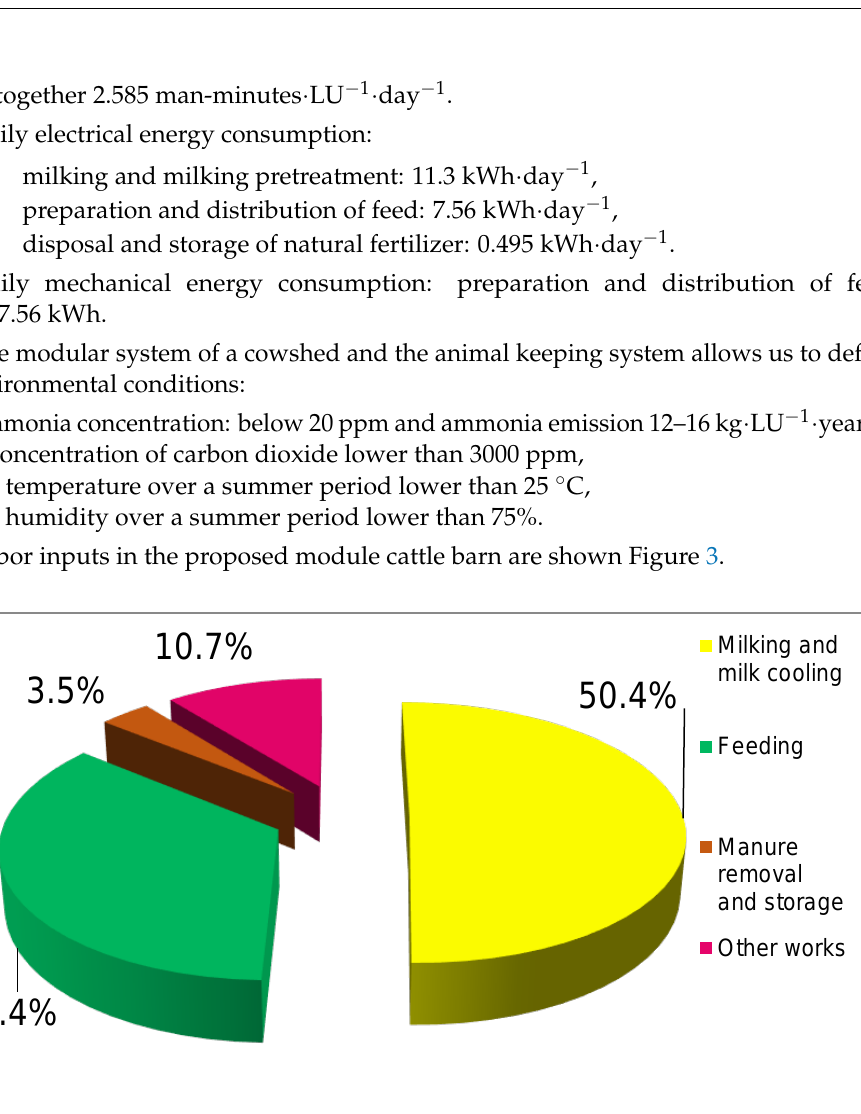
Figure 3. Percentage of labor inputs in the module cattle barn.